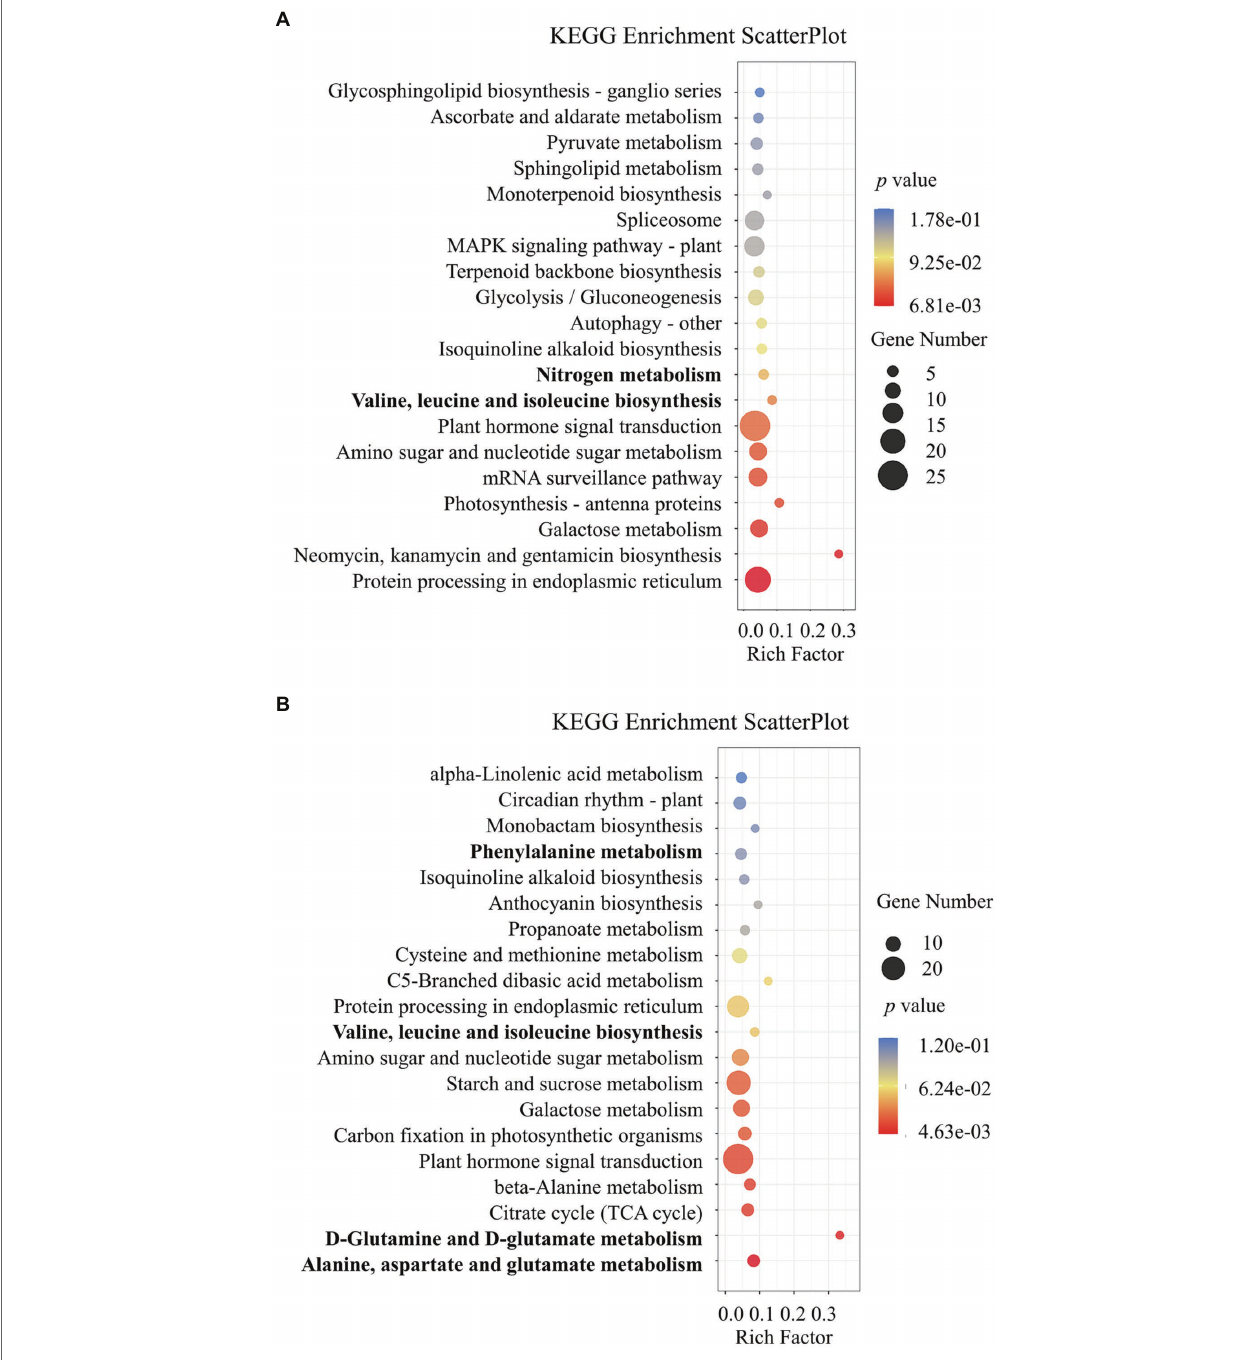
FIGURE 4 | KEGG pathway analysis of identified differentially expressed cis and trans target genes. (A) represent NO 3- vs. NH 4 NO 3 comparsion and (B) represent NH 4- vs. NH 4 NO 3